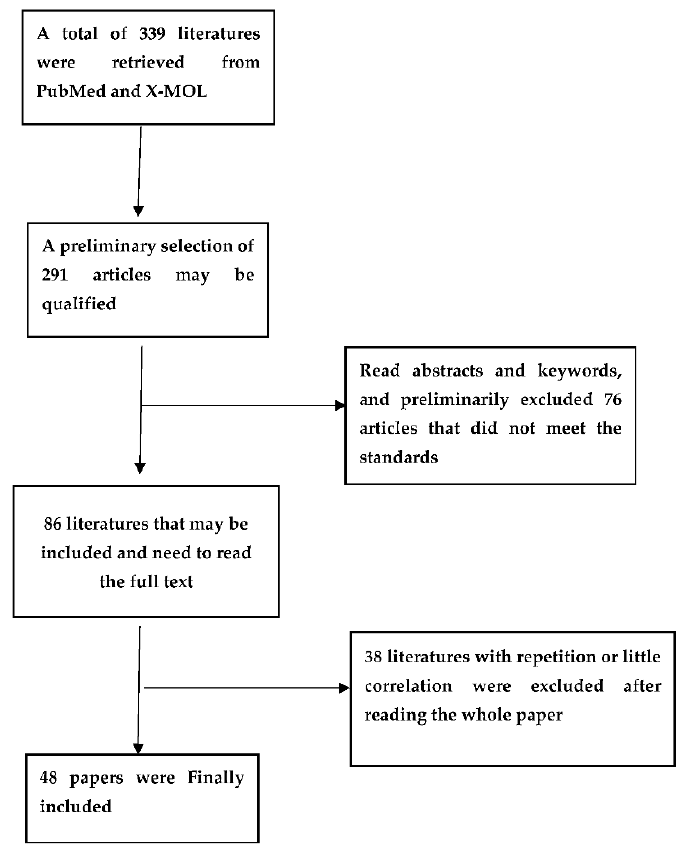
Figure 1. Flow diagram for the literature selection.